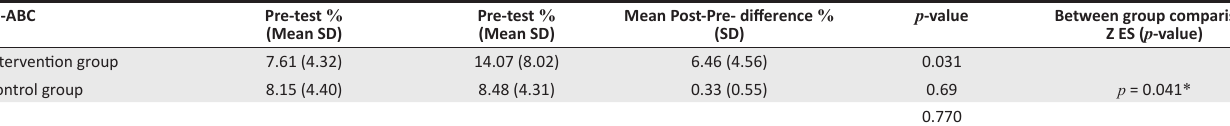
TABLE 3: Movement Assessment Battery for Children (M-ABC) scores pre- and post-intervention. M-ABC Pre-test % (Mean SD) Intervention group